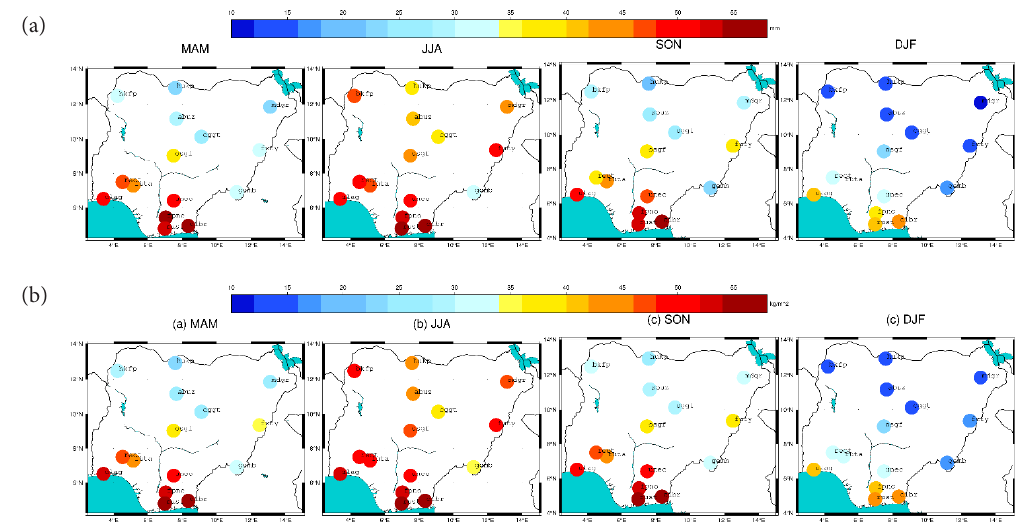
Figure 8. Seasonal means: a – GNSS PWV (mm); b – ERA5 PWV (kg/m 2 ) for MAM, JJA, SON, and DJF from